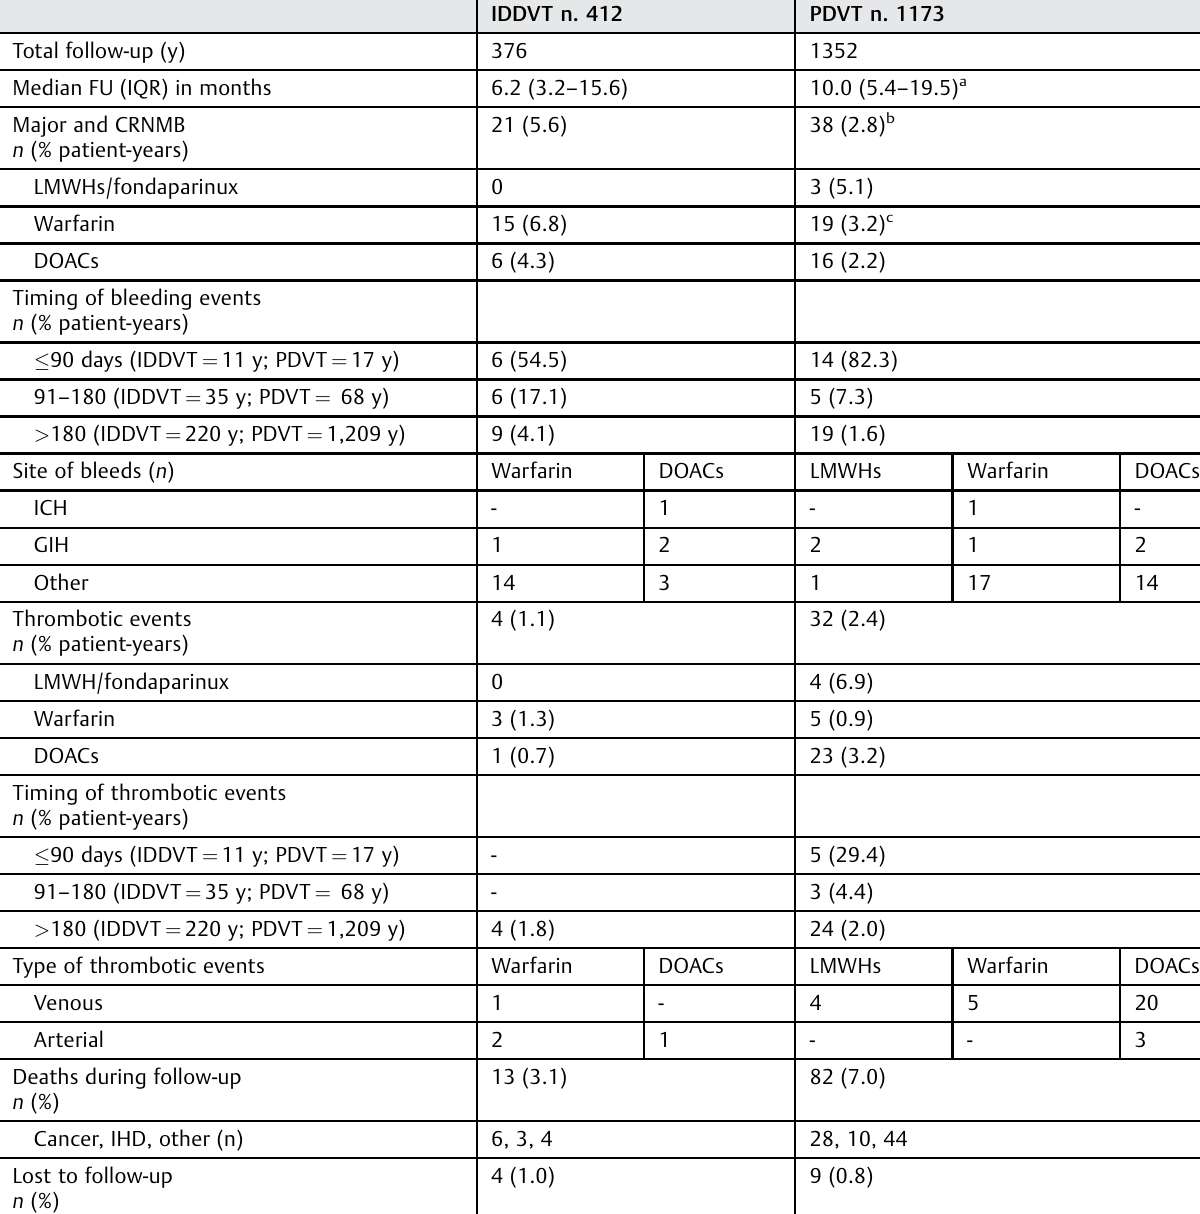
Table 3 Bleeding and thrombotic complications occurred during treatment in patients with IDDVT or PDVT IDDVT n.